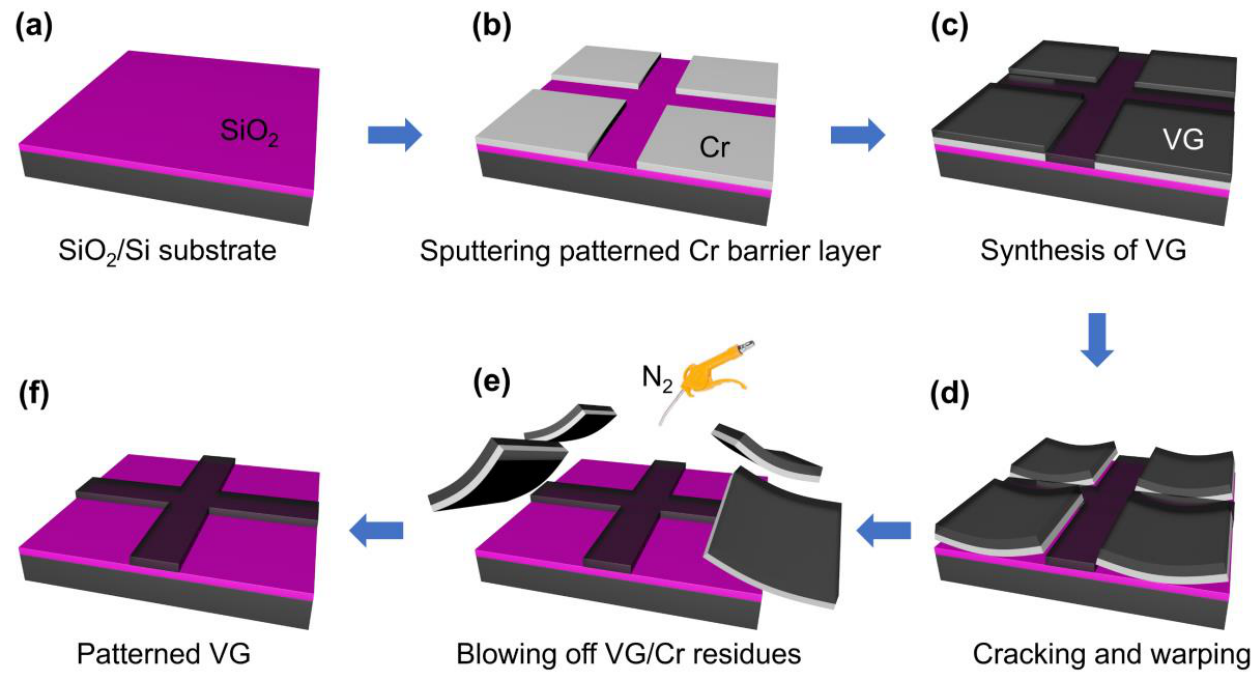
Figure 1. Schematic illustration of the growth process for the patterned VG. ( a ) SiO 2 /Si substrate on which the patterned VG was grown. ( b ) Sputtered Cr barrier layer was deposited on the substrate to define the blank area of VG. ( c ) VG was synthesized by PECVD. ( d ) The VG/Cr cracked and warped, and then separated from the substrate during the cooling process. ( e ) Residual VG/Cr debris left on the substrate was blown off by N 2 . ( f ) The patterned VG was generated.